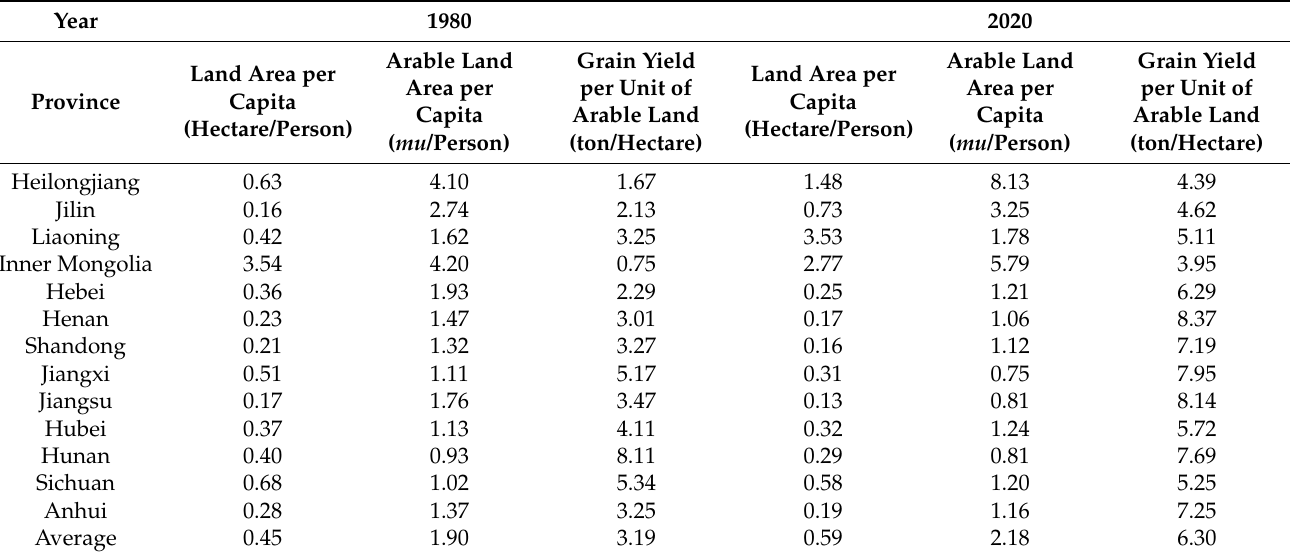
Table 2. Land resources use status of China’s major grain-producing areas in 1980 and